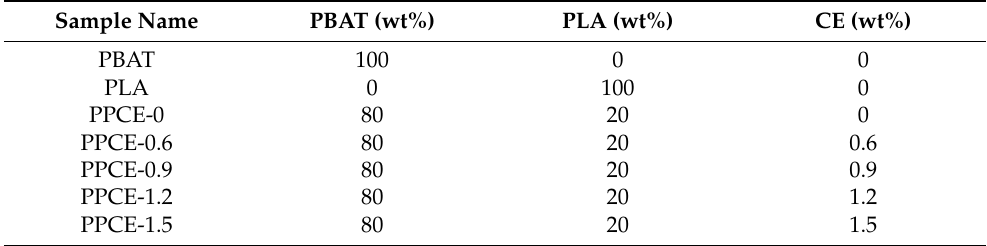
Table 1. Experimental formulae of different PBAT, PLA, and PBAT/PLA blend samples.